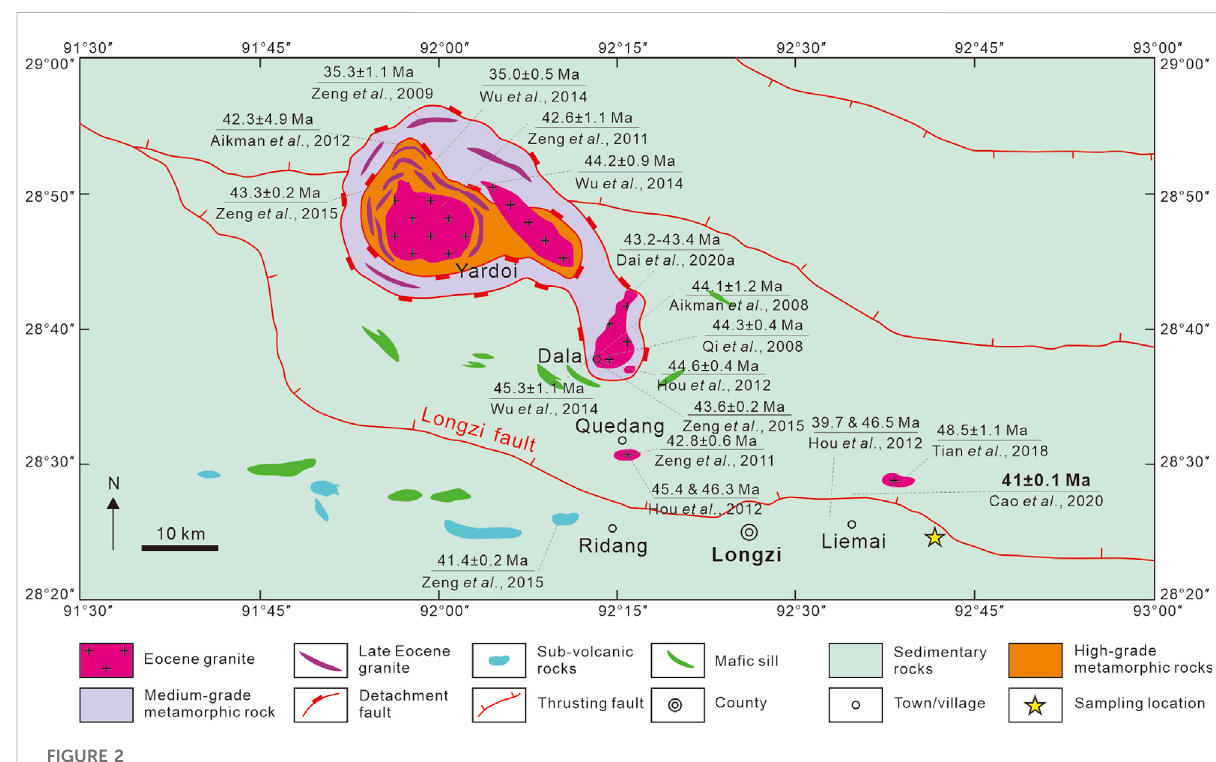
FIGURE 2 Simpli fi ed geological map of the Yardoi area showing the Yardoi gneiss dome and distribution of Eocene granites (modi fi ed after Dai et al. (2020a) and Cao et al.